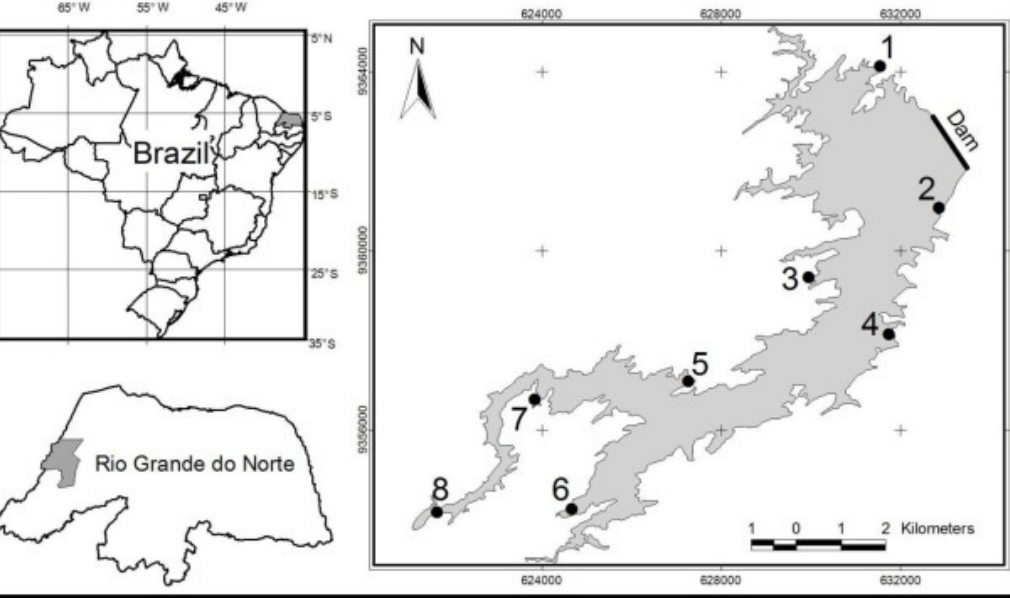
Figure 1. Santa Cruz Reservoir is in the Apodi-Mossoró River Basin, Apodi, Rio Grande do Norte, Brazil. The positions of collection sites 1 and 8 are